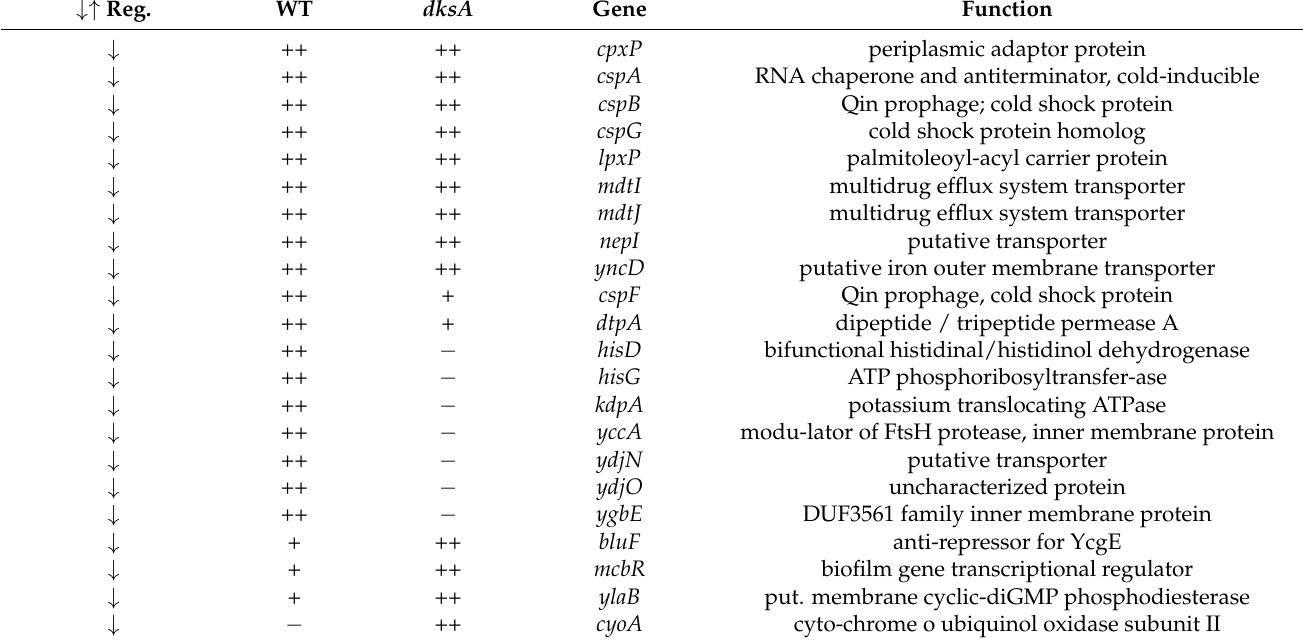
Table A1. The most up- and downregulated host genes. The following genes of the wild type or dksA mutant hosts were found to be the most up- or downregulated hosts genes upon phage infection (regardless the time points). Double plus (++) represents host genes listed as the top ten most regulated at each time-point (the same as shown in Figure 3C or Figure 3D). One plus (+) indicates the host genes that were up- or downregulated, but their expression was lower than the top ten (therefore they were not shown in Figure 3). Minus ( − ) indicates that a gene was neither up- nor downregulated in the host. Arrows ( ↓ ↑ ) indicate the direction of